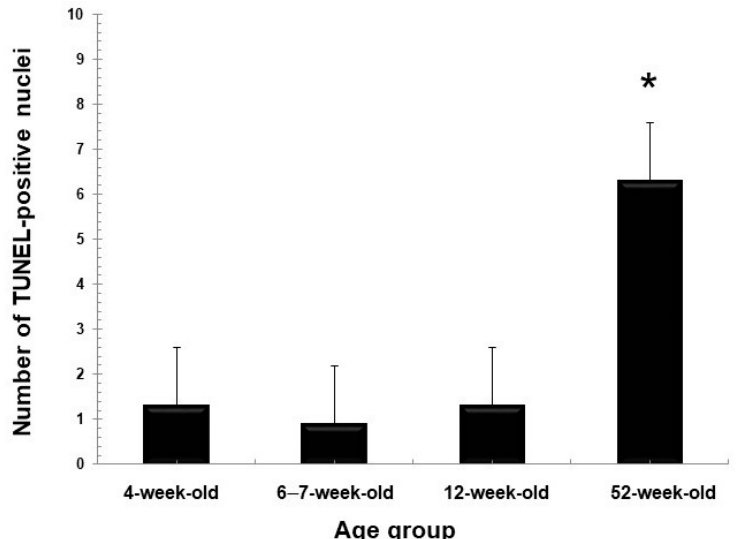
Figure 12. Number of TUNEL-positive nuclei in the epithelia of rete testis and efferent ducts of the testicular excurrent duct system of Japanese quails at 4, 6–7, 12, and 52 weeks of age ( n = 3 per age group), expressed as mean ± SE. * TUNEL-positive cell counts were significantly ( p < 0.001) higher in 52-week-old birds compared to the other age groups.